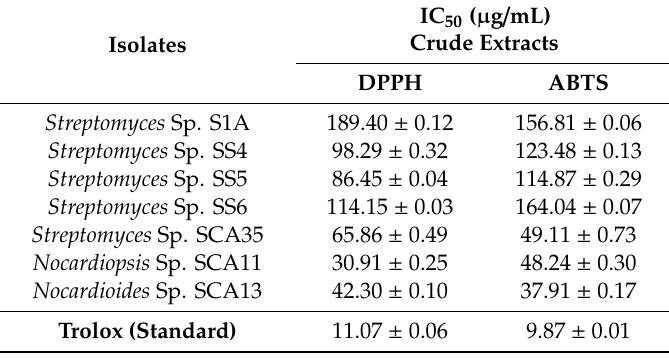
Table 5. Comparison of IC 50 ( µ g / mL) of crude extracts and trolox for DPPH and ABTS radical scavenging